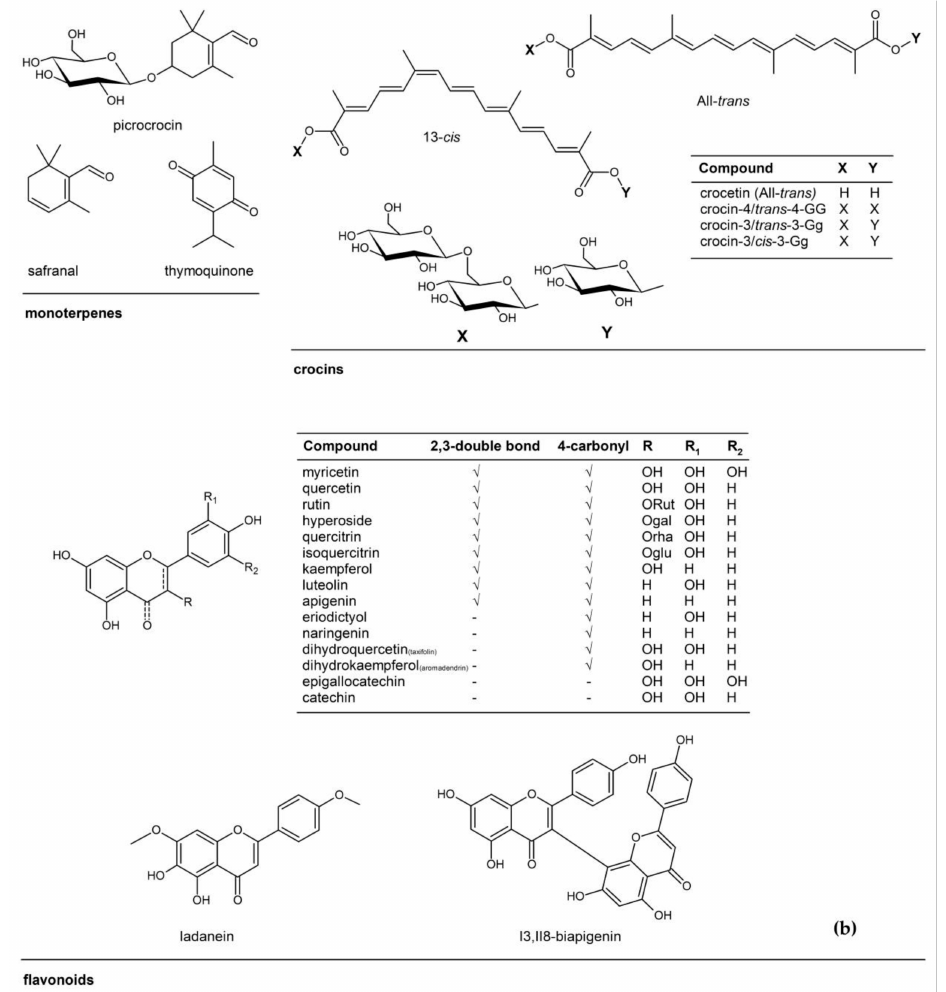
Figure 1. The structures of representative members from different groups of bioactives, contained in the reviewed aromatic plants. ( a ): Hydroxybenzoic acids, hydroxycinnamic acids and derivatives, phenolic diterpenes, triterpenic acids, phloroglucinols, and naphthodianthrones. ( b ): Monoterpenes, crocins, and